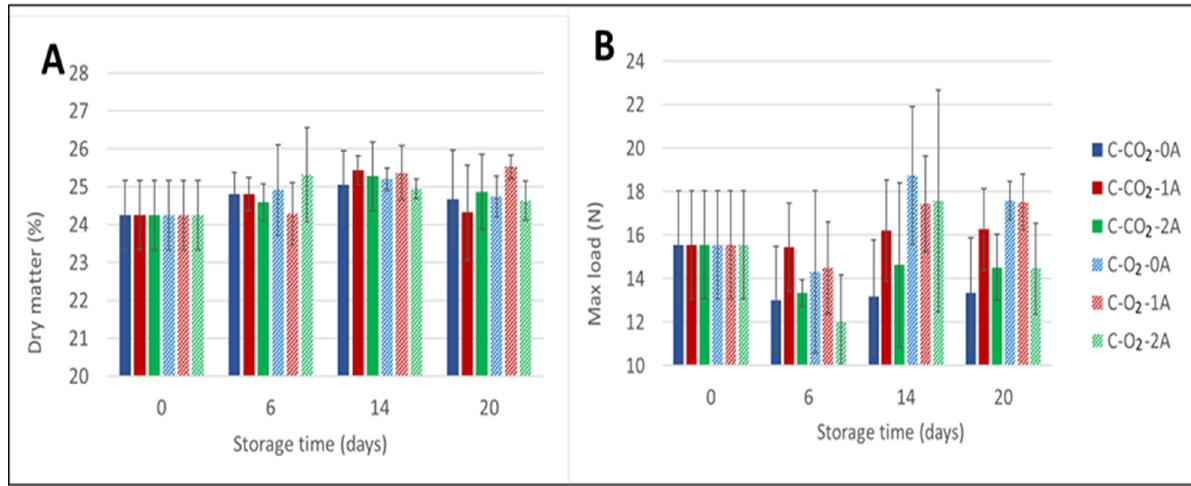
Figure 2. Percentage dry matter content measured for chicken breast fillets ( A ) (two replicates per sample variant) and Warner–Bratzler maximum shear force (N/cm 2 ) (WBSF) required to cut cooked samples of chicken breast fillets ( B ) (presented as an average of 6 replicates per sample variant). The chicken breast fillets (C) were stored in modified atmospheres of 60% CO 2 /40% N 2 (C-CO 2 ) and 75% O 2 /25% CO 2 (C-O 2 ) (g/p 1.8) with 0, 1, or 2 liquid absorbent pads (0A, 1A, 2A) (Experiment 1) and sampling times of 0, 6, 14, and 20 days.